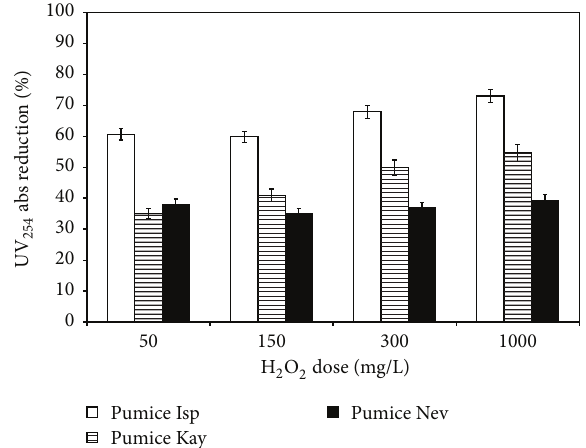
Figure 6: The effects of the pumice source on NOM removal performances of the hybrid process. < 63 𝜇 m iron oxide-coated pumice, pumice dose: 3000 mg/L. Error bars indicate the 95% confidence